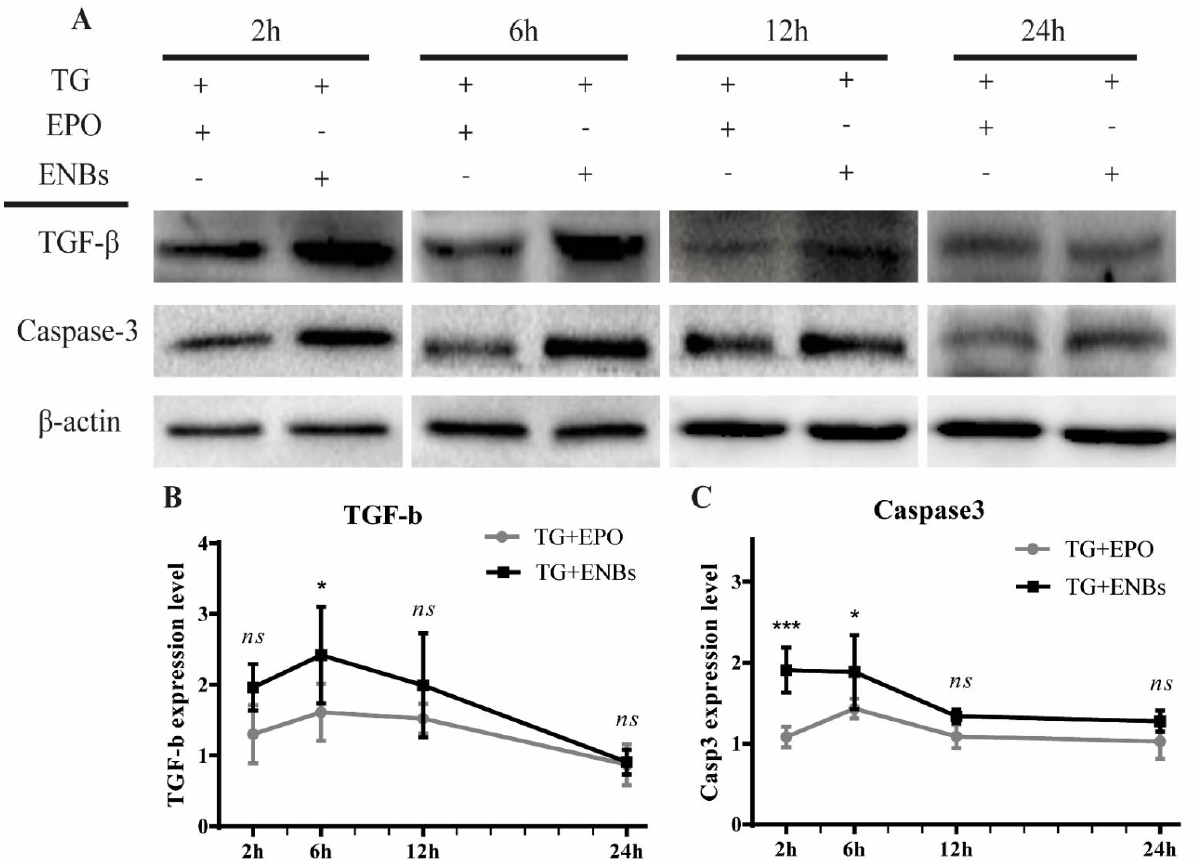
Figure 6. Endoplasmic reticulum stress-induced apoptotic signaling pathway deactivation ( A ) determinded by Western blot analysis and ( B , C ) quantified over 24 h. β-Actin was used as a loading control. TG indicates thapsigargin treatment, TG + EPO indicates thapsigargin and EPO cotreatment, and TG + ENBs indicates thapsigargin and EPO nanobot cotreatment. TGF-β, transforming growth factor-beta. * p < 0.05, *** p < 0.001, and ns, not significant versus TG + EPO cotreatment.